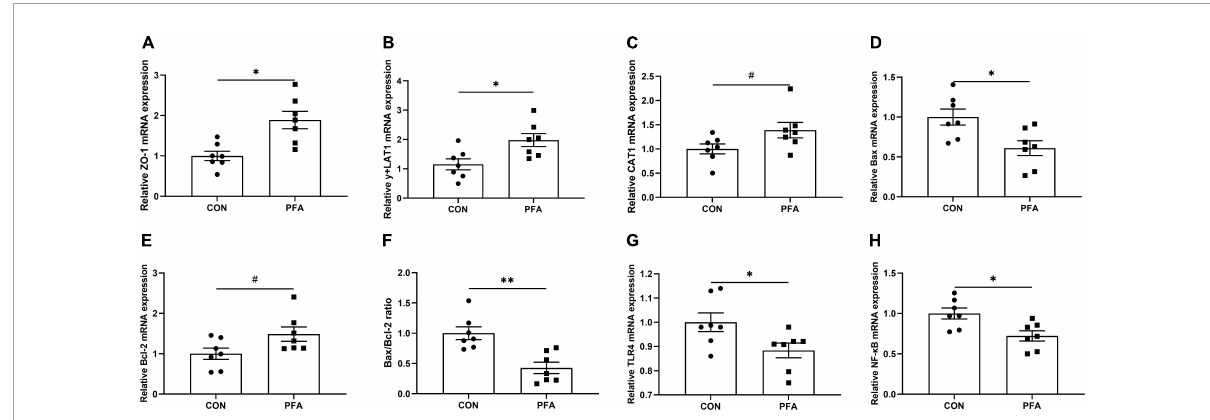
FIGURE3 Effect of dietary paraformic acid supplementation on relative mRNA expression in intestinal mucosa of broilers. (A) Zonula occludens-1 (ZO-1); (B) y + L amino acid transporter 1 (y + LAT1); (C) Cationic amino acid transporter 1 (CAT1); (D) Bax; (E) Bcl-2; (F) Bax/Bcl-2 ratio; (G) Toll-like Receptor 4 (TLR4); (H) Nuclear factor-kappa B (NF- κ B). CON, broiler chickens fed basal diet; PFA, broiler chickens fed basal diet supplemented with 1,000 mg/kg paraformic acid. Values are mean ± standard error ( n = 7). Differences between treatments were displayed by # 0.05 ≤ P < 0.10, ∗ P < 0.05, and ∗∗ P <